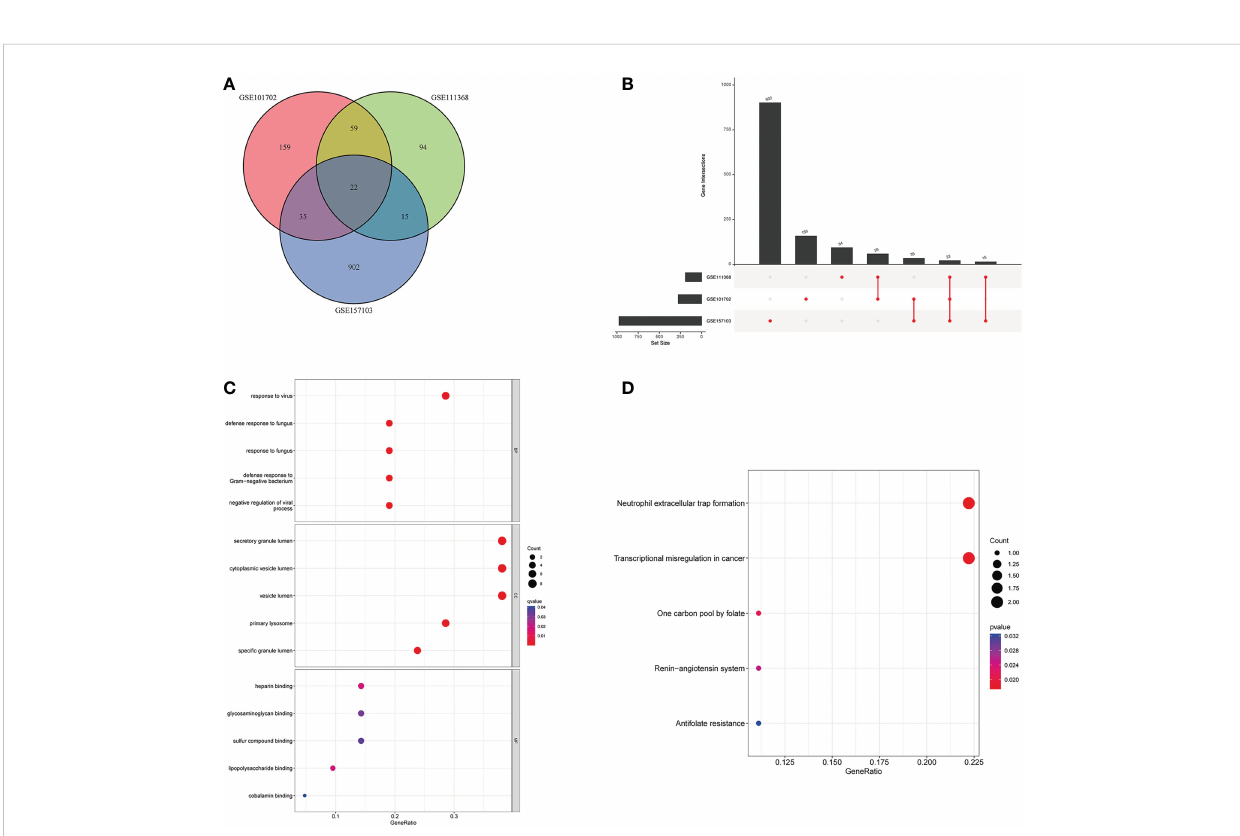
FIGURE 3 Molecular functional analysis of intersecting DEGs. (A) Intersectional differential gene Venn diagram, (B) Intersectional differential gene Up Set diagram, (C) Bubble for GO enrichment analysis of DEGs, (D) Bubble for KEGG enrichment analysis of